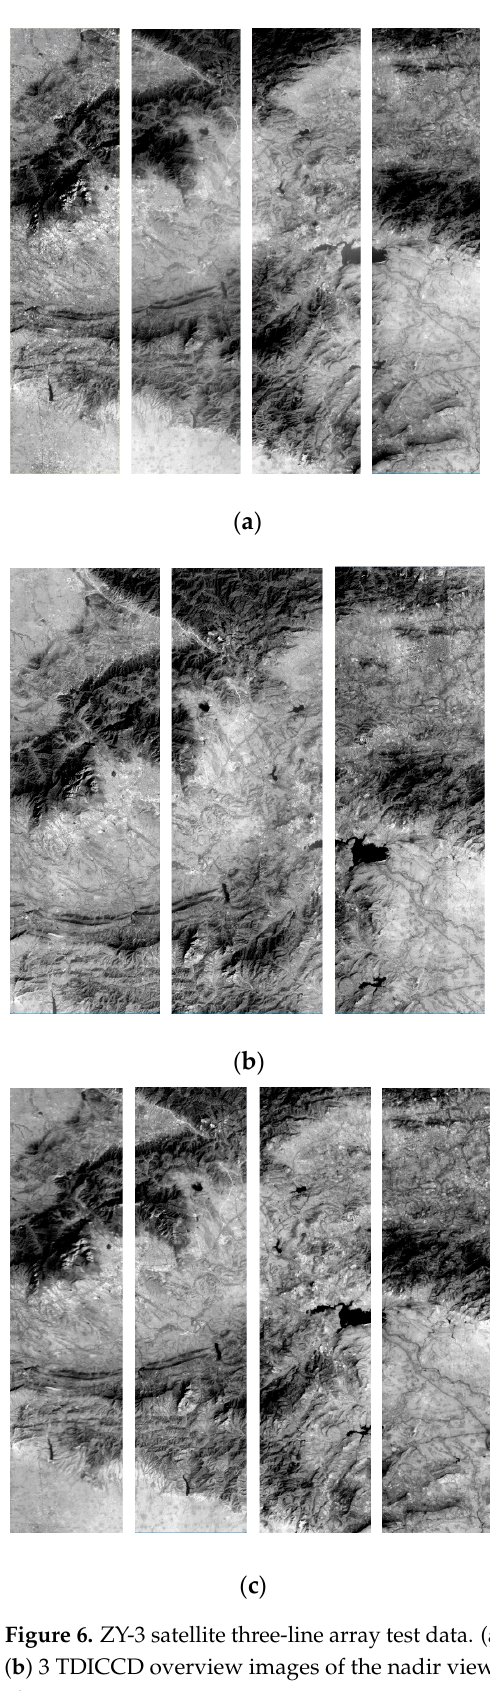
Figure 6. ZY-3 satellite three-line array test data. ( a ) 4 TDICCD overview images of the forward view; ( b ) 3 TDICCD overview images of the nadir view; ( c ) 4 TDICCD overview images of the backward